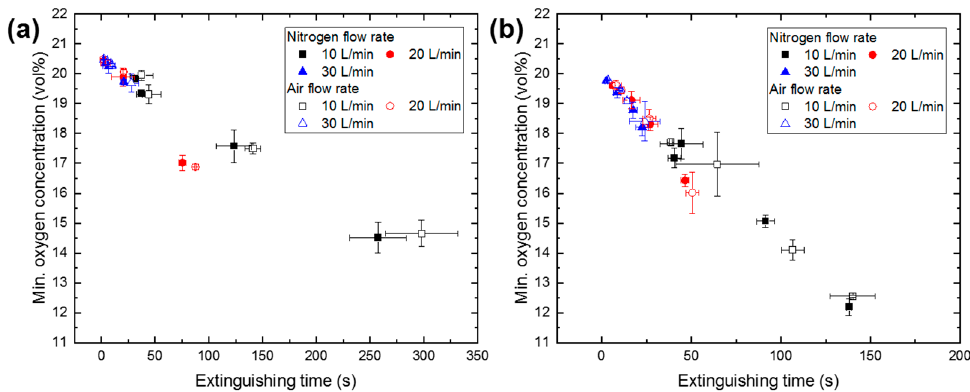
Figure 14. Extinguishing time vs. minimum oxygen concentration for gas type effect (note that the scales of x -axis in both figures are different): ( a ) HRR = 1.17 kW and ( b ) HRR = 5.23 kW.